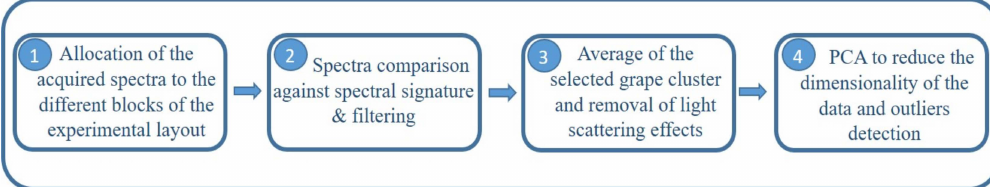
Figure 5. Design of the spectral processing procedure required to analyze on-the-go spectral measurements of grape clusters under field